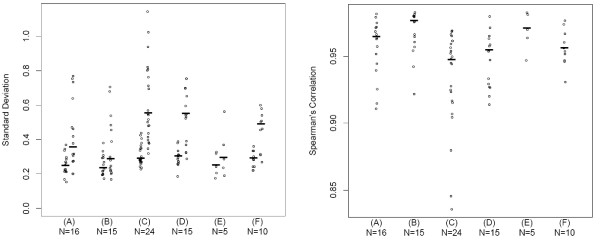
Standard deviations and correlations. Left box: Standard deviations (SD) summarizing variability in probe differences corresponding to the bias curves in Figure 3. The left column of points for each panel is for the low abundance probes, the right column of points is for the high abundance probes. A horizontal mark indicates the median SD for each column. Right box: Spearman's correlation values, r, assessing association of replicates. A horizontal line indicates the median r value for each panel. These data change little after normalization (data not shown). The descriptions for sections A – F within the boxes are the same as those described for Panels A – F in Figure 3.